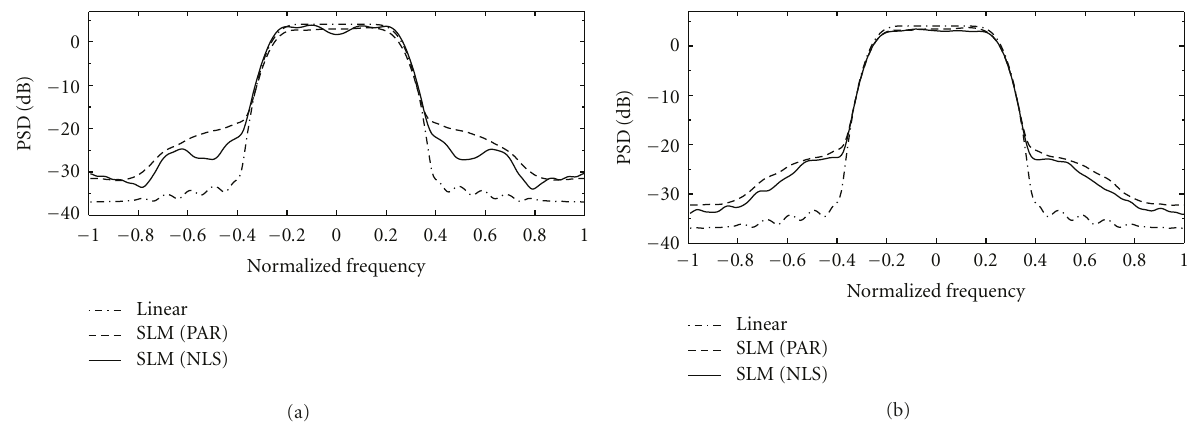
Figure 6: PSDs of 16-user CDMA signals in presence of PD-HPA at (a) IBO = 1dB and (b) IBO =